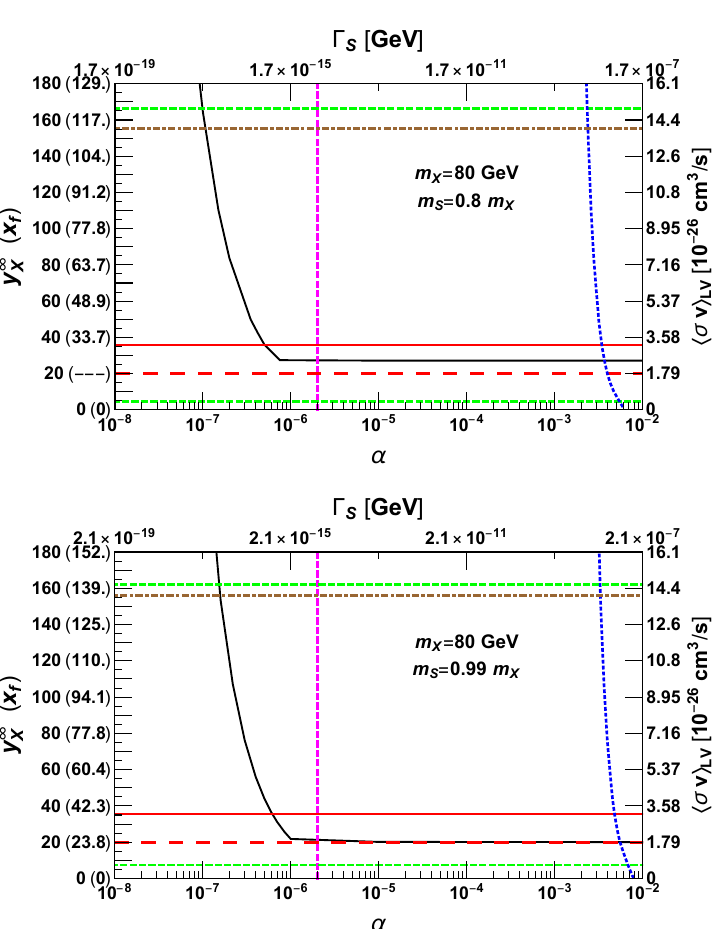
Figure 8 . Contour of having the correct relic abundance (black curve) on the ( (cid:11) (cid:0) y 1 ) plane. On X the top, the value of the S decay width (cid:0) S , which is a function of (cid:11) , is labeled. Here for a given (cid:11) , we (cid:12)ne-tune the value of g dm from the numerical analysis of Boltzmann equations to obtain y 1 , X which matches the observed relic abundance determined by eq. (4.19). From each set of allowed parameters, we get x f from the relation given by eq. (5 : 1), and further have the corresponding value h (cid:27)v i LV ( (cid:17) h (cid:27)v i (0) ) from eq. (4.19) or from the value of g dm . The dependence of h (cid:27)v i LV on (cid:11) XX ! SS is negligible. The 95% C.L. upper limit from CMB is denoted as the dot-dashed (brown) line. The 95% C.L. upper limit and project sensitivity for dSphs observations are shown as horizontal solid (red) and long-dashed (red) lines, respectively. The r.h.s. of the dotted (blue) curve corresponds to projected reach by LZ. When (cid:11) is larger than that denoted by the vertical dashed (magenta) line, the dark sector is well in the chemical and thermal equilibrium with the bath before freeze out. The region between the two horizontal short-dashed (green) lines provides a good (cid:12)t to the GC gamma-ray excess.